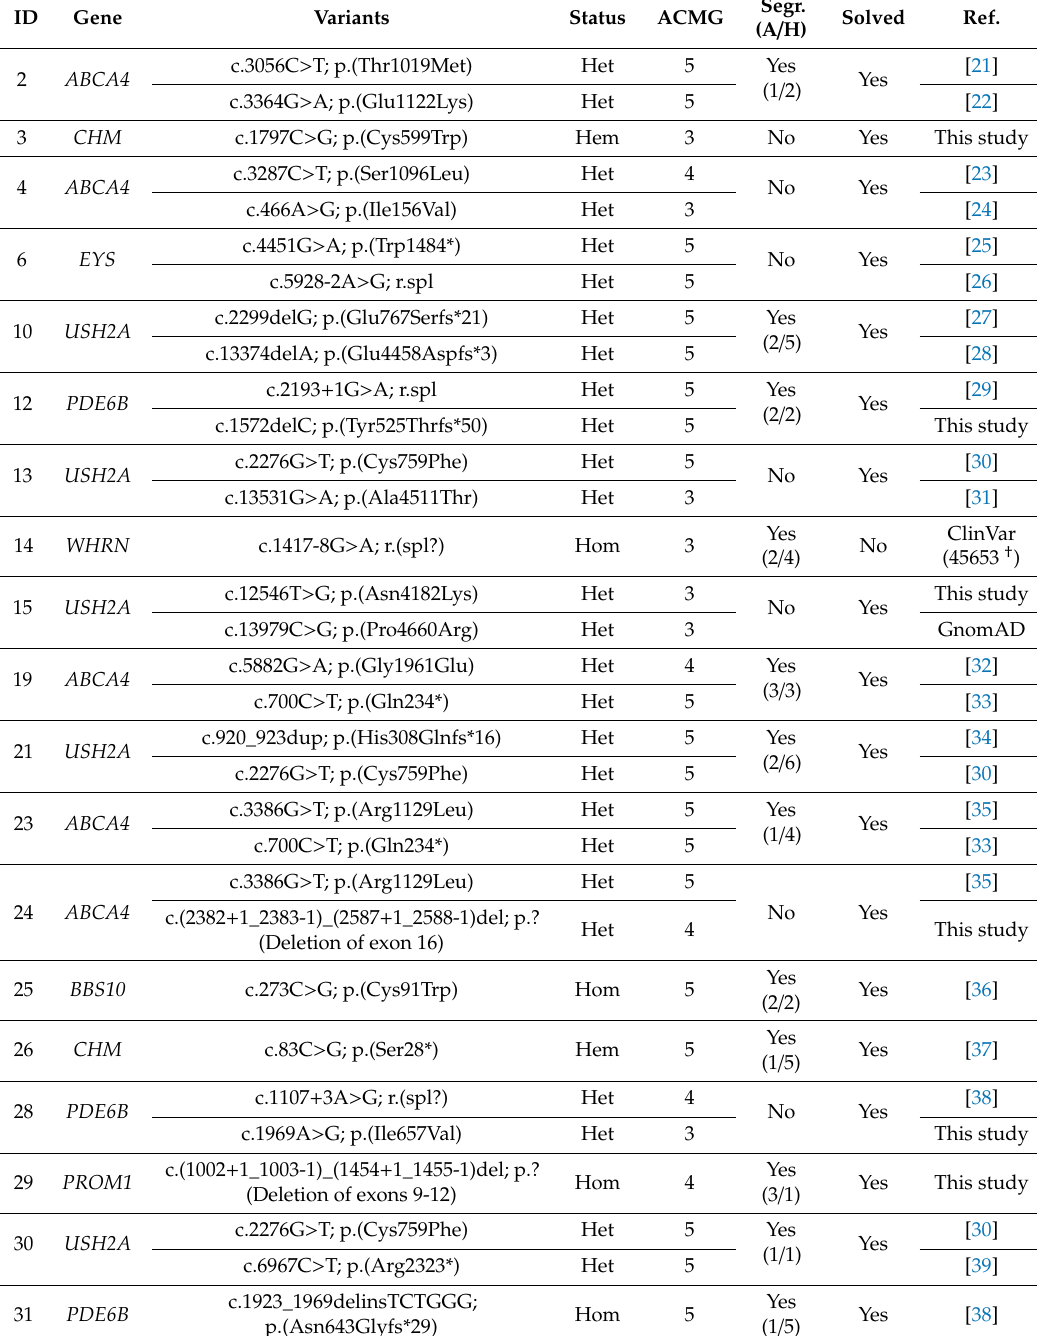
Table 1. Likely pathogenic mutations found in IRD-associated genes by panel